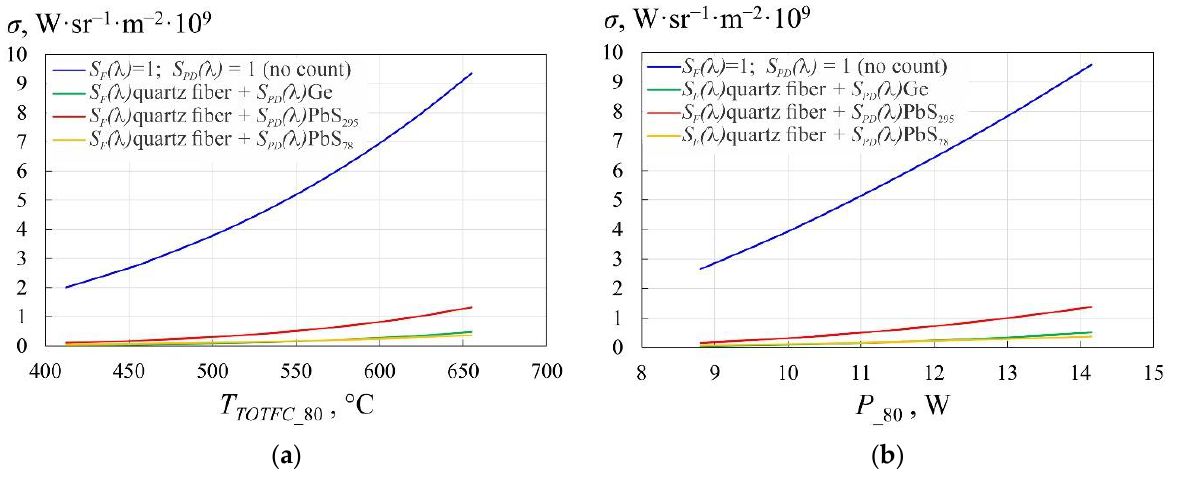
Figure 9. The dependence of the spectral luminosity density TOTFC σ (in the wavelength range 1–6 µ m) on T TOTFC _80 ( a ) and P _80 ( b ) without taking into account S F ( λ ) and S PD ( λ ) and considering S F ( λ ) and S PD ( λ ) for varied PD (the wavelength of laser radiation is 980 nm, the inner vein diameter is 5